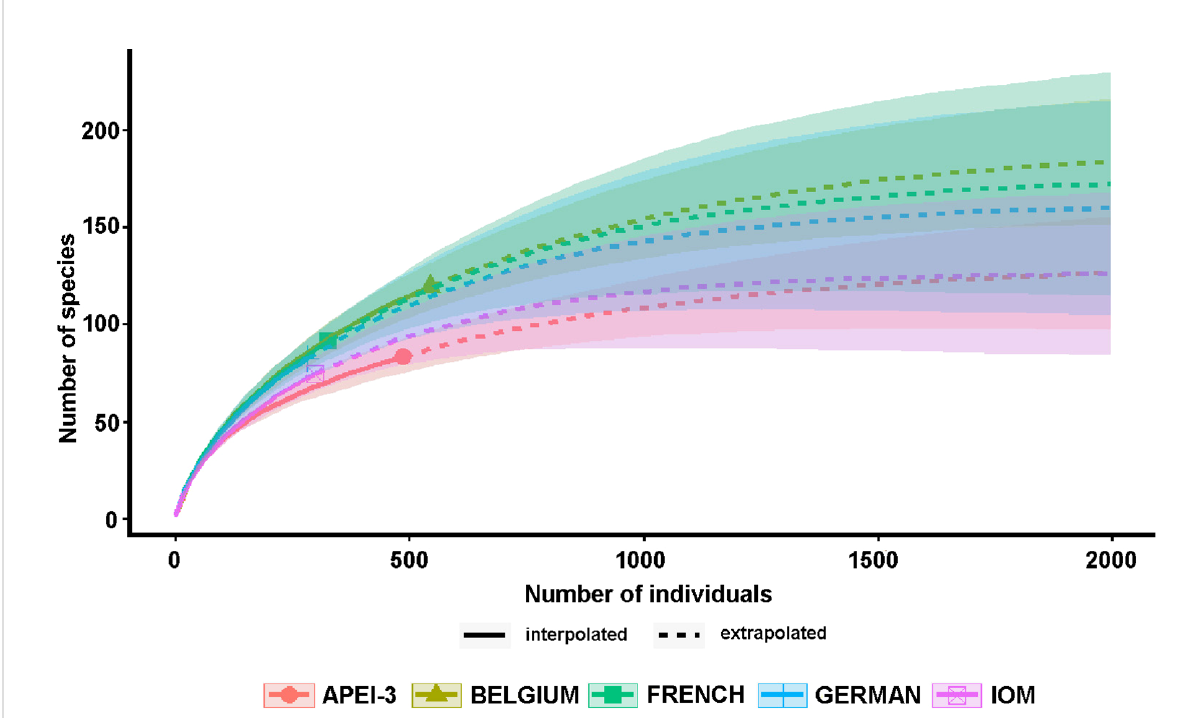
FIGURE 7 Sample-size-based rarefaction and extrapolation curves, estimating foraminiferal species richness as a function of the sample size (specimen number) up to double the reference sample size (Chao et al., 2014).